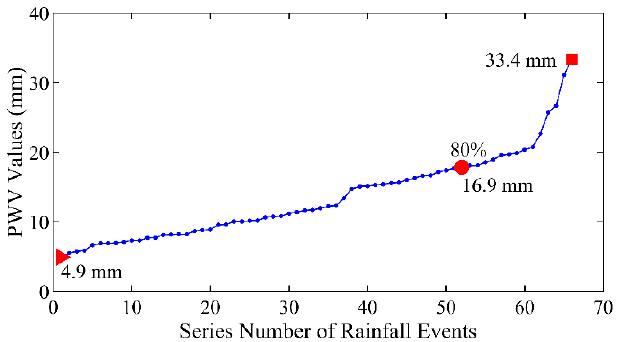
Figure 6. PWV values before onset of 66 rainfall events in January of a 9-year period at 726166-54781-VTBE station. The blue line represents the PWV values from the minimum value to the maximum value before onset of the 66 rainfall events. The red triangle, dot, and quadrangle represent the minimum value, the value at the position of 80%, and the maximum value, respectively. Table 5. Statistic result for each candidate threshold of the prediction factor of PWV value in January at the 726166-54781-VTBE station.